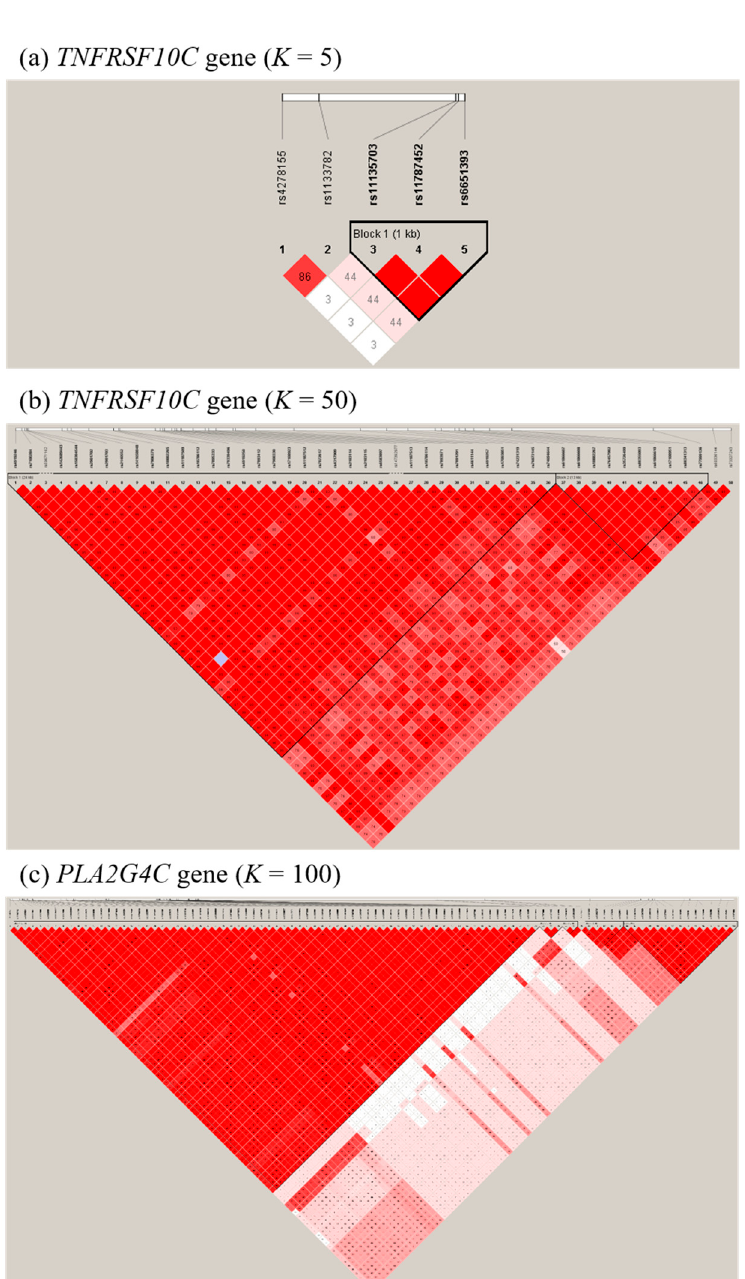
Figure 3. Linkage disequilibrium (LD) patterns of genes used in simulation studies: ( a ) TNFRSG10C gene ( K = 5); ( b ) TNFRSF10C gene ( K = 50); ( c ) PLA2G4C gene ( K = 100). Numbers indicate the D ʹ values expressed as percentiles. A standard color scheme is used to display the LD pattern, with red for perfect LD ( r 2 = 1), white for no LD ( r 2 = 0) and shades of pink/red for intermediate LD (0 < r 2 < 1).